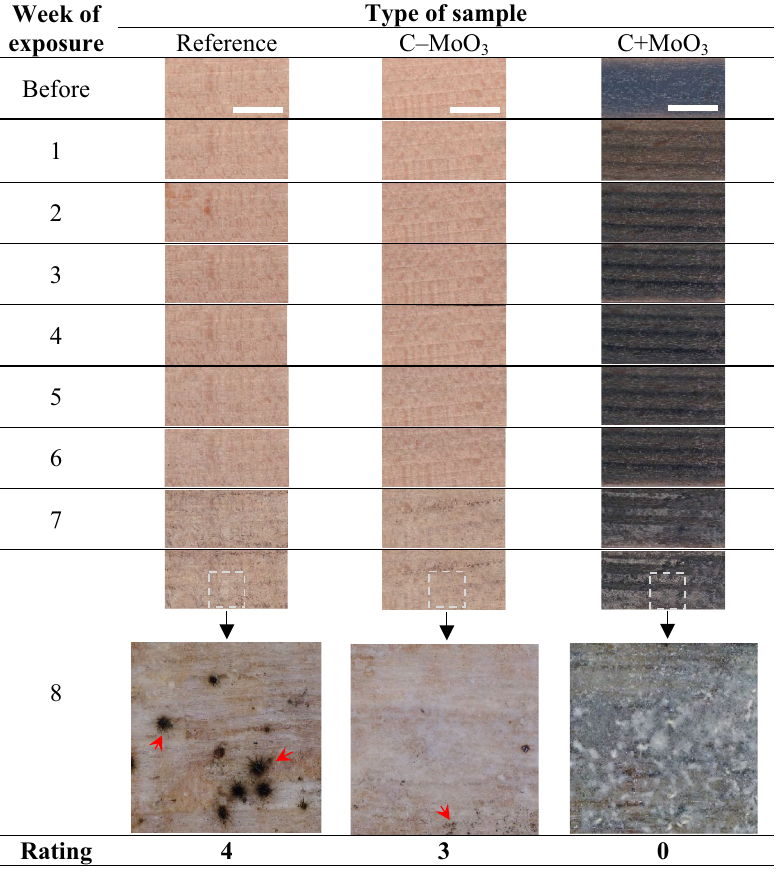
Table 4. The results of the resistance to mould growth test for each type of sample and the corresponding rating. The red open arrows indicate the presence of mould conidiophores in wood. The length of the scale bars is 10